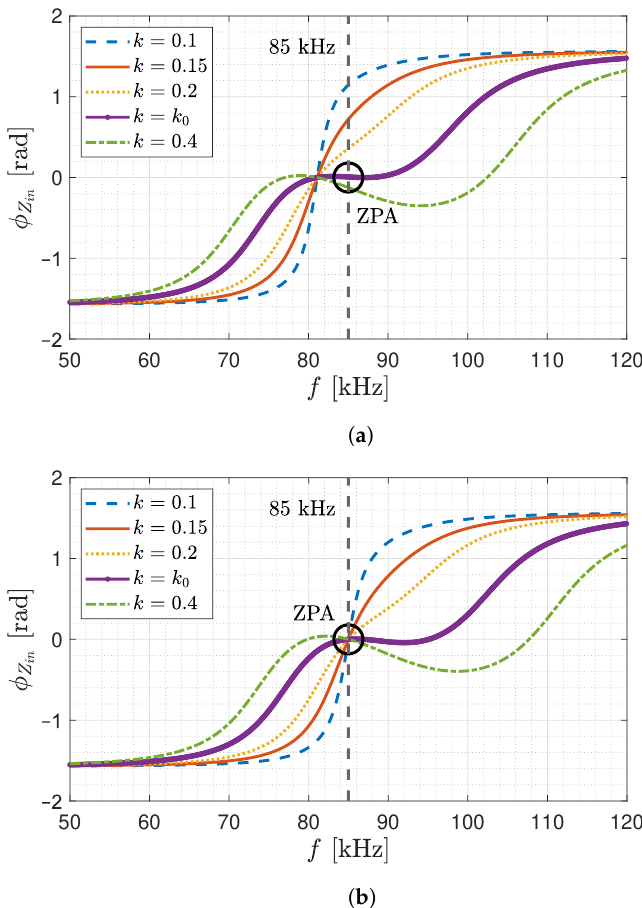
Figure 6. Input impedance angle as a function of the frequency for different coupling coefficients in case of inductive link designed for ( a ) CV output and ( b ) coupling independent ZPA operations at f 0 = 85